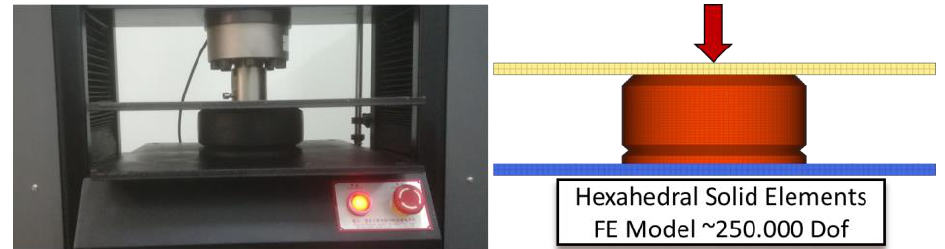
Figure 2. Experimental set-up of the buffer in the tension-compression test machine (left) and FE model of buffer and steel plates equivalent to the experimental set-up (right).